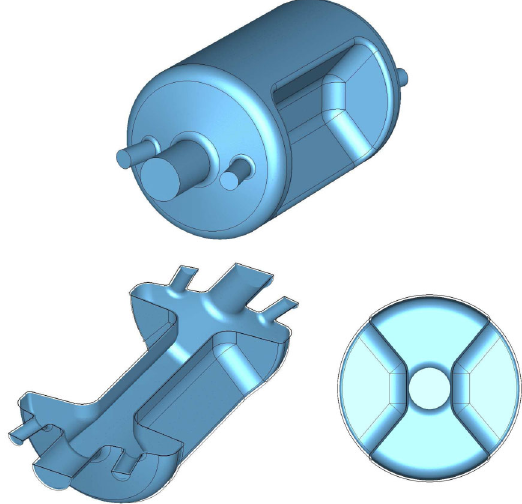
FIG. 1. Radio-frequency–dipole geometry and cross